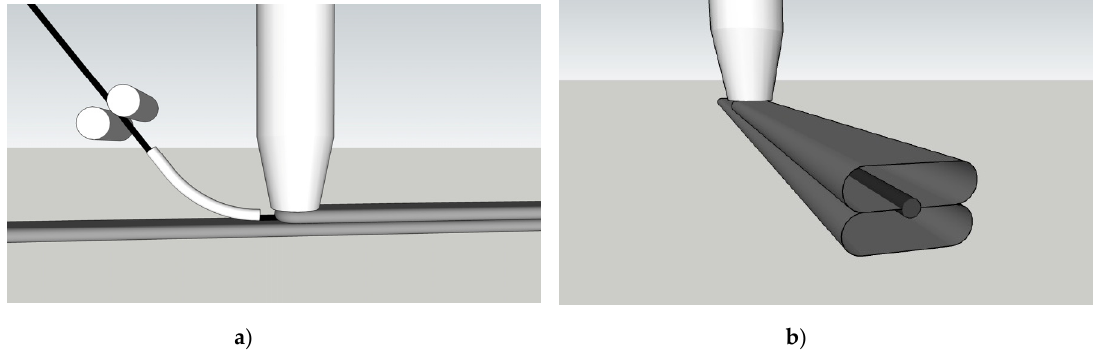
Figure 6. Integrating MCF between concrete filaments: ( a ) yarn supply scheme, and ( b ) cross-section of two printed concrete layers with MCF reinforcement in between.